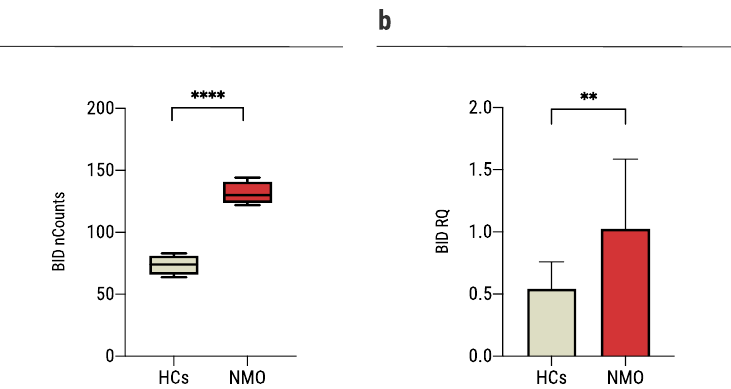
Figure 2. Exposure of astrocytes to sera of NMO patients increased BID expression. ( a ) The